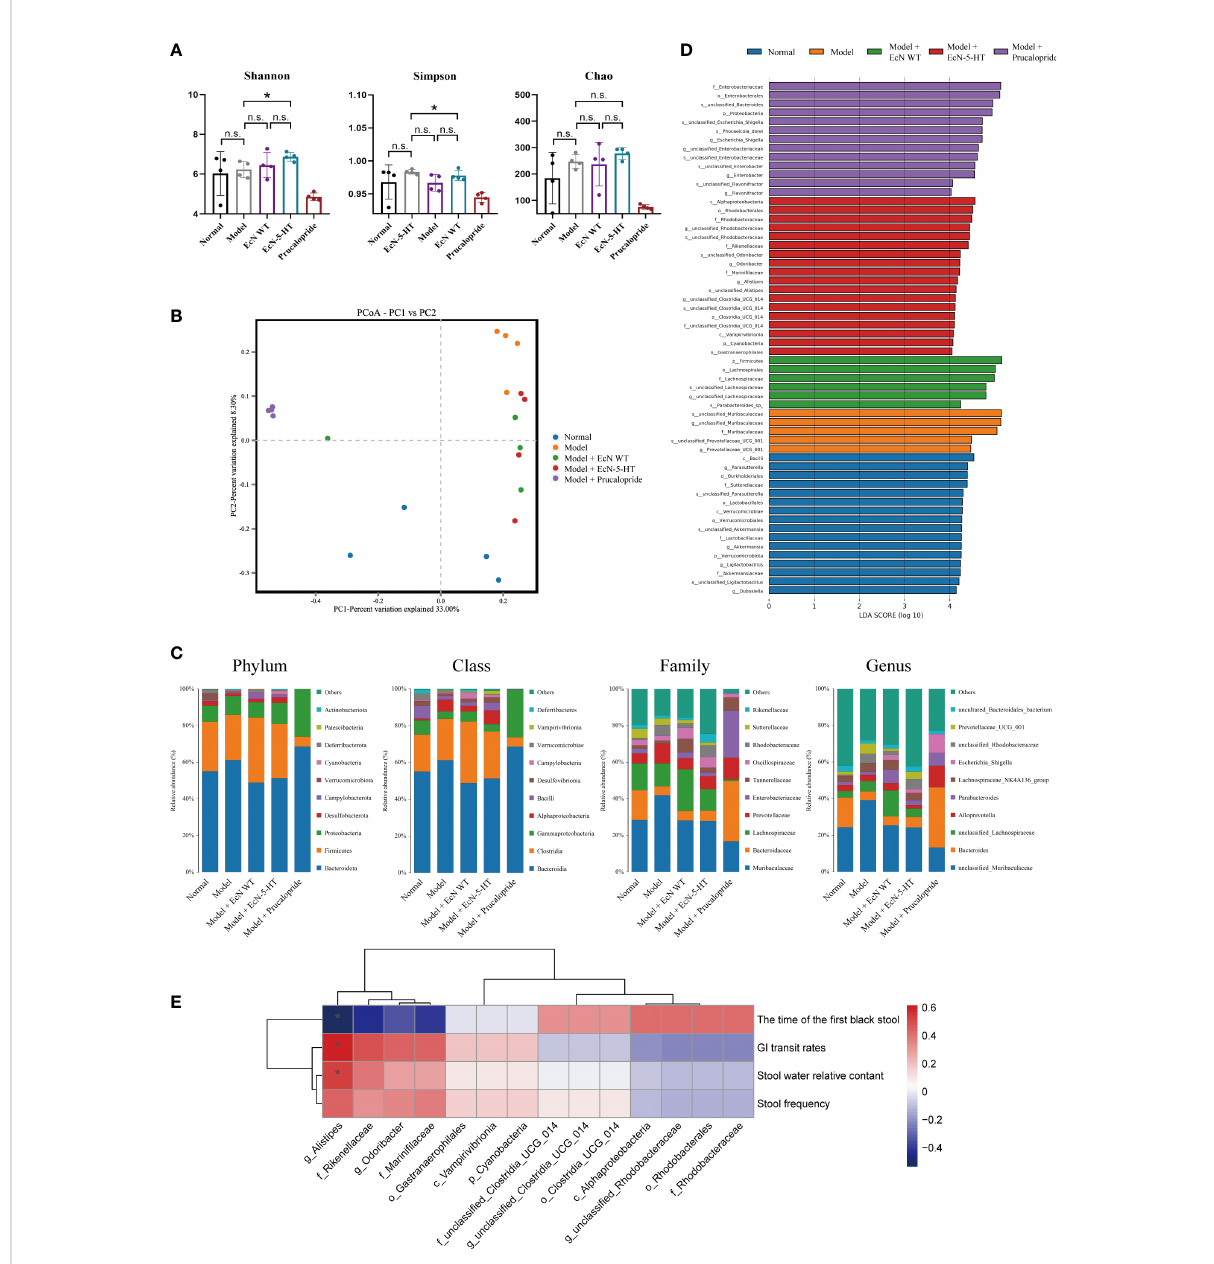
FIGURE 5 Effects of EcN-5-HT on intestinal microbiota in a constipation mice model. (A) Alpha diversity boxplot analysis. (B) Principal coordinate analysis (PCoA) pro fi le of microbial diversity. (C) Relative abundance of microbial community at different taxonomic levels. (D) LDA score computed from features differentially abundant between the groups. (E) Spearman correlation analysis. Red and blue colors represent signi fi cant positive correlations and negative correlations. The color depth represents the correlation coef fi cient, and the darker the color, the greater the correlation coef fi cient. Mean values ± SDs are presented, p values were calculated using unpaired t-test, *p < 0.05, n.s: not signi fi cant. Data are pooled from three independent experiments with n = 4 mice per